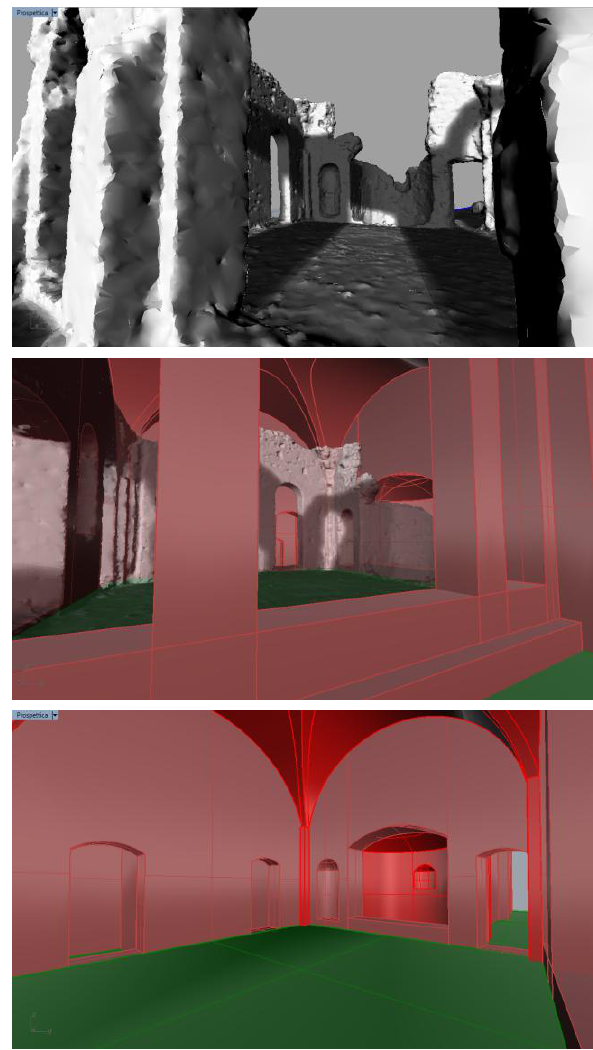
Figure 6. Augmented reality of the thermal area, Massaciuccoli archaeological site. From top to bottom views: 3D model obtained by meshing the laser scanning point cloud (top); modeling the past age by accurately following the geometric information of the current remains (central); virtual 3D reconstruction of a thermal room (H and L in Figure 2) as it appeared in the past